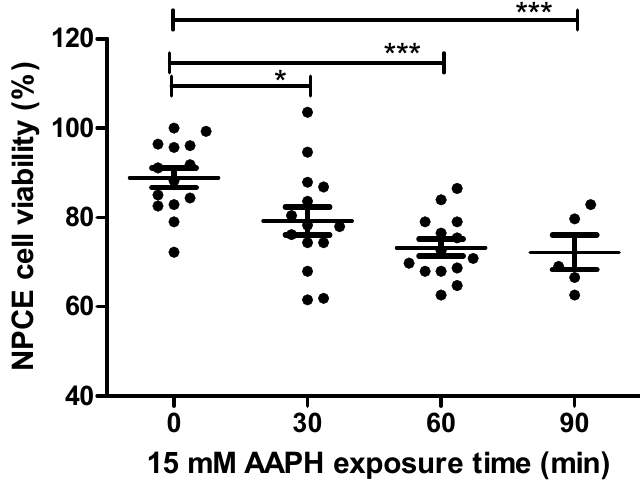
Figure 1. Cell viability of AAPH-treated NPCE cells. Cell viability was measured by MTT assay in NPCE cells at 30, 60, 90 min after 15 mM AAPH treatment. Data are expressed as percent viability and represented by mean ± SEM. Multiple group comparisons were performed using one-way analysis of variance (ANOVA) followed by the post hoc Tukey’s test, and any difference in comparison with untreated NPCE cells was considered significant when * p < 0.05 or *** p < 0.001.